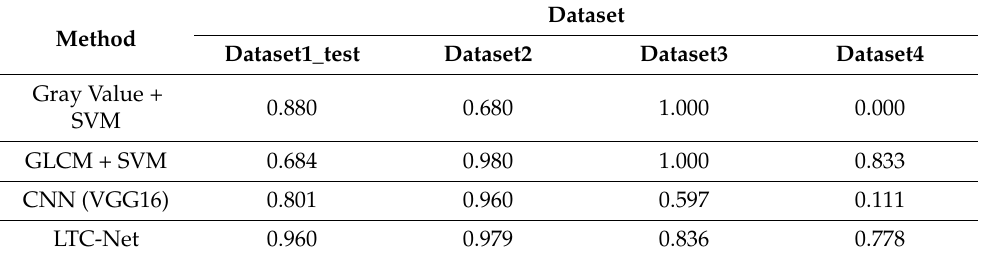
Table 4. Recall of coal.